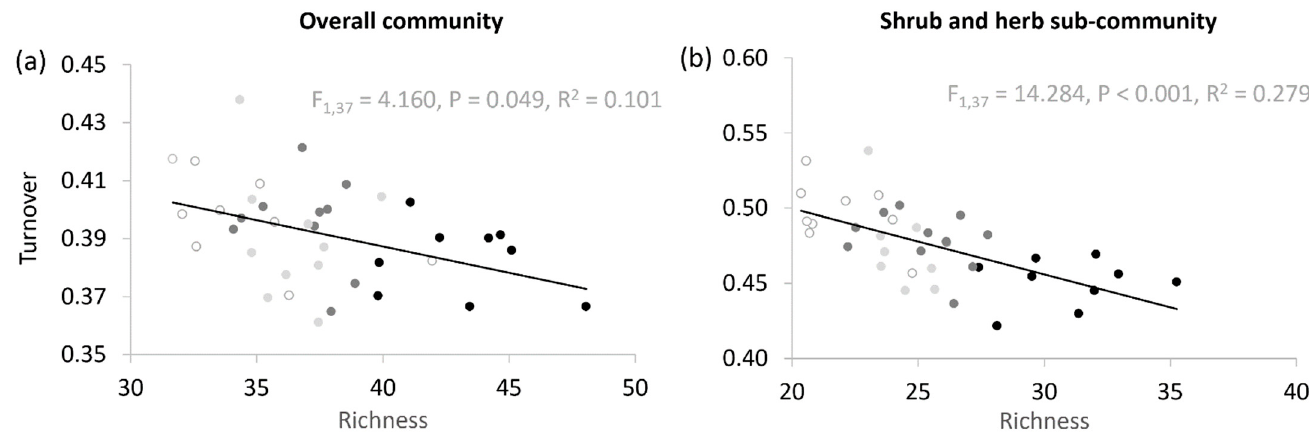
Figure 5. Relationship between taxonomic turnover (higher = greater) between 39 sequential 100-year time periods and taxonomic richness in the earlier of those time periods for sites in western Eurasia for: ( a ) overall vegetation community; and ( b ) shrub and herb sub-community. In both cases, data points for sequential 100-year periods falling between present day and 1,000 years ago are shaded black, those 1000–1999 years ago are shared dark grey, those 2000–2999 are shaded light grey and those 3000–3999 are open circles. Note that scales differ between graph panels.